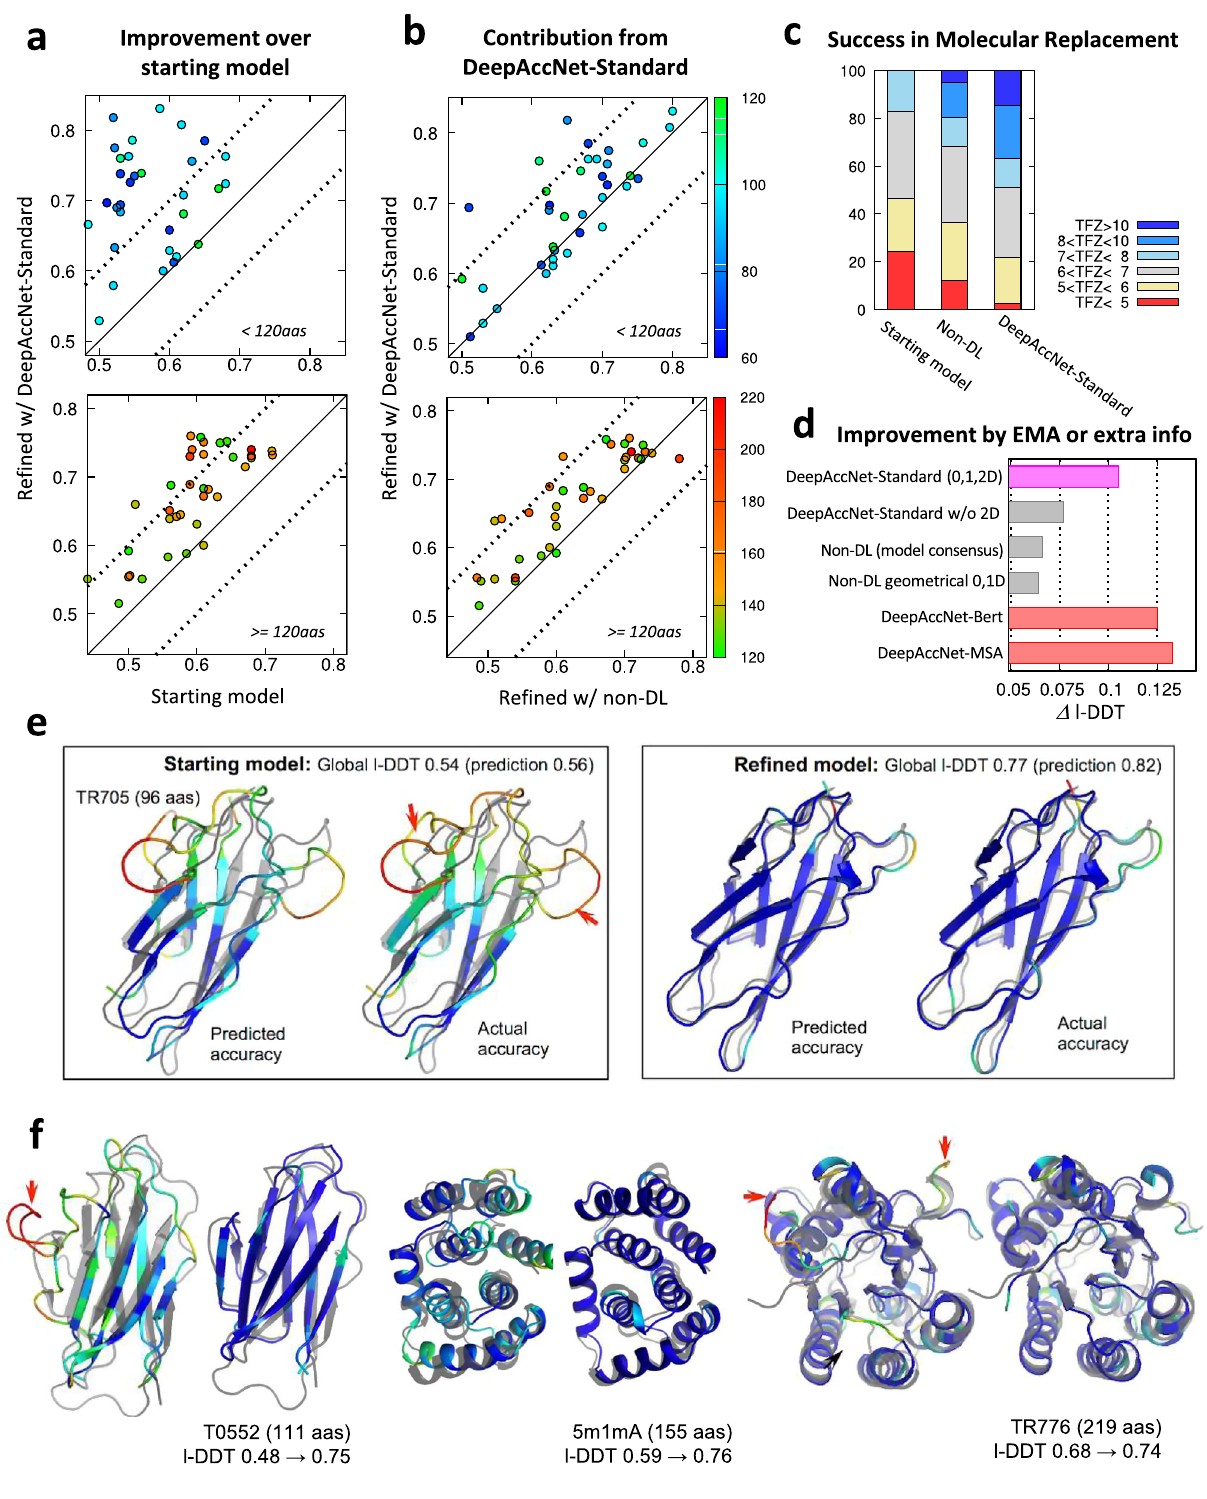
benchmark set, the fraction of cases for which robust MR hits were obtained was 0%, 20%, and 37% using prere fi ned models, models re fi ned by the non-deep learning protocol, and models re fi ned using DeepAccNet-Standard, respectively.